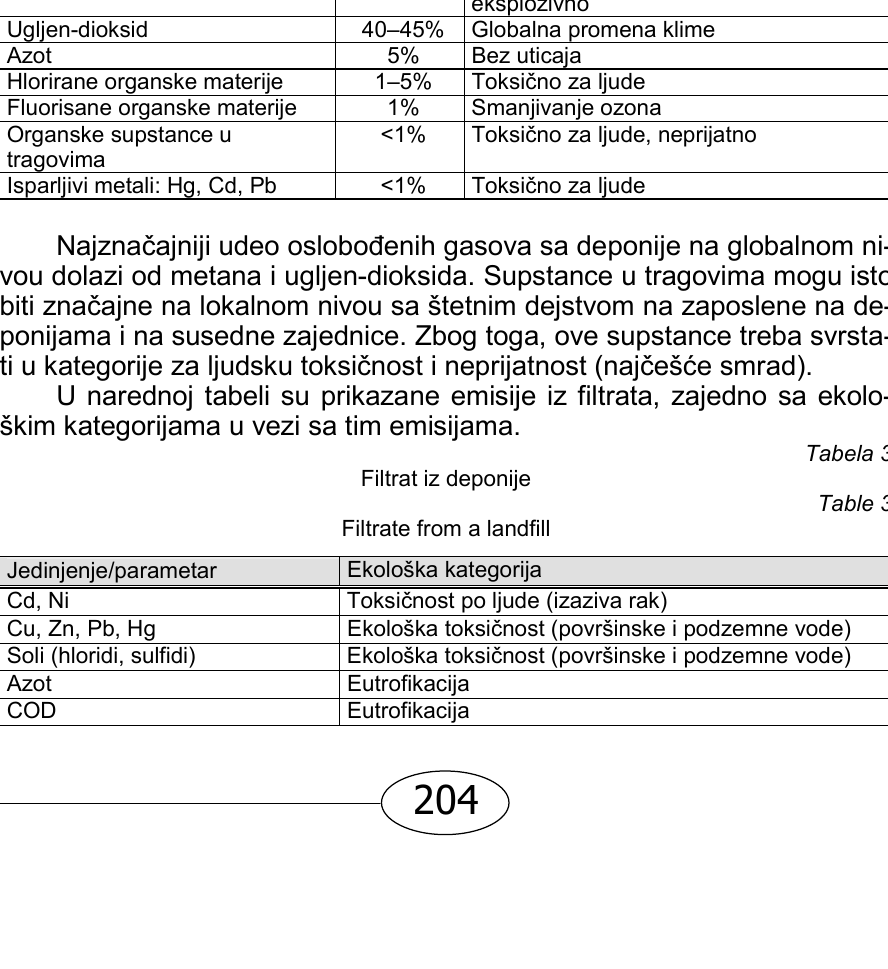
21 tona ugljen-dioksida.